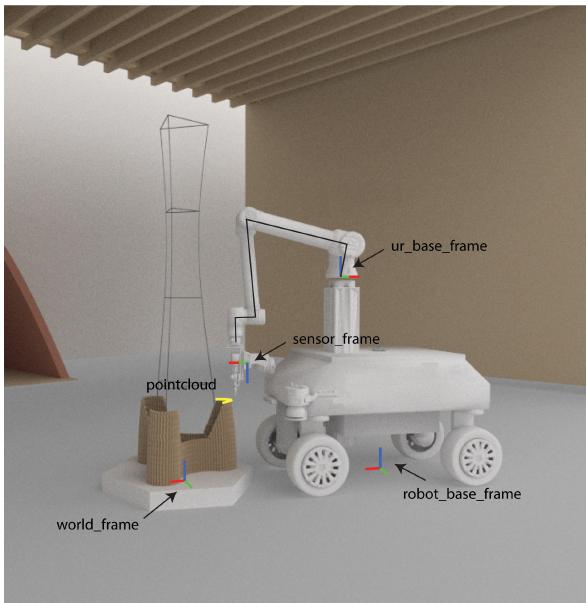
Figure 2. The 2D laser scanner at the robot’s end effector is used to estimate the robot’s base frame by aligning the two 3D point clouds captured from the 3D-printed object each time after a print job of one segment has been carried out, and before continuing a print job from a new Figure 1. A 9-axis mobile construction platform for clay formwork extrusion equipped with a two-stage localization system comprising a) a Laser Range Finder on the base for rough localization via 2D SLAM in a world map, and b), a 2D Profile Laser Scanner on the end-effector for refined localization relative to the 3D-printed object.